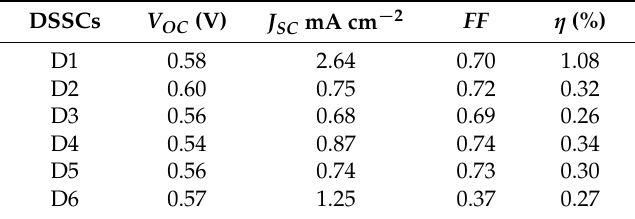
Figure 7. Current-Voltage curves of DSSCs sensitized with the six natural dyes. Table 5. Measured photovoltaic parameters of the fabricated